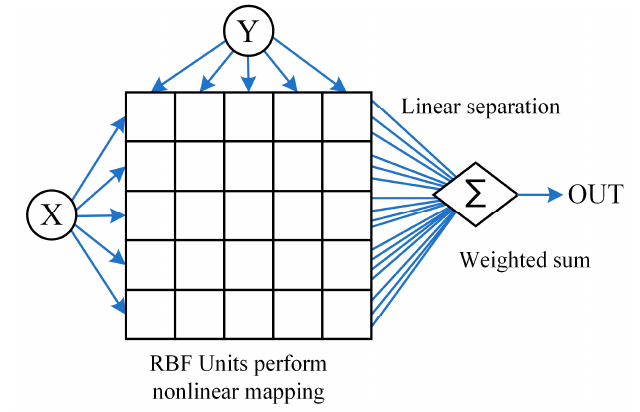
Figure 12. Structure of RBF networks.